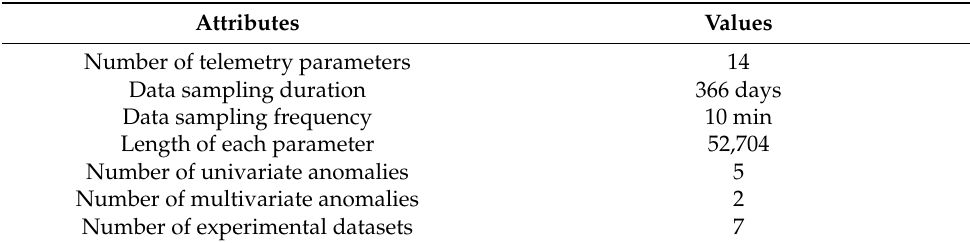
Table 1. Description of